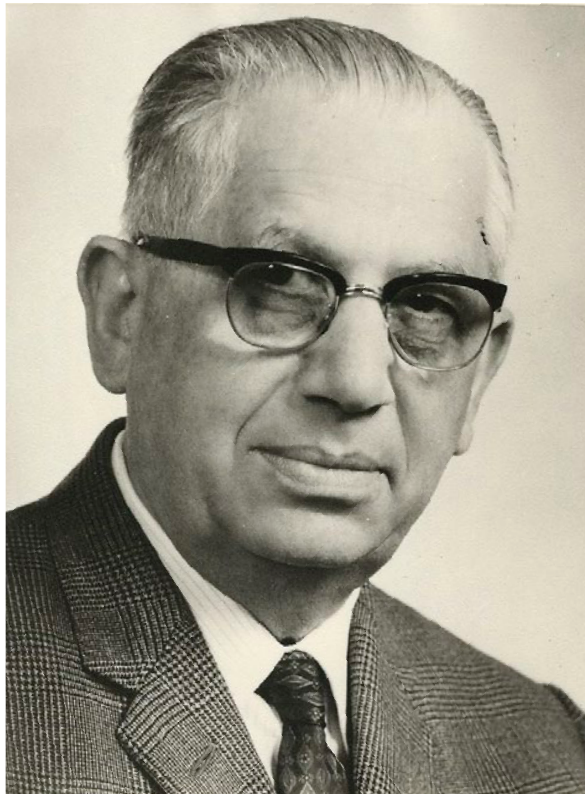
Figure 7. Zvi in Jerusalem, 1970; (from the private collection of the Jolles-Bainbridge family, now in the Fondo Jolles at Florence Uni- versity Museum of Natural